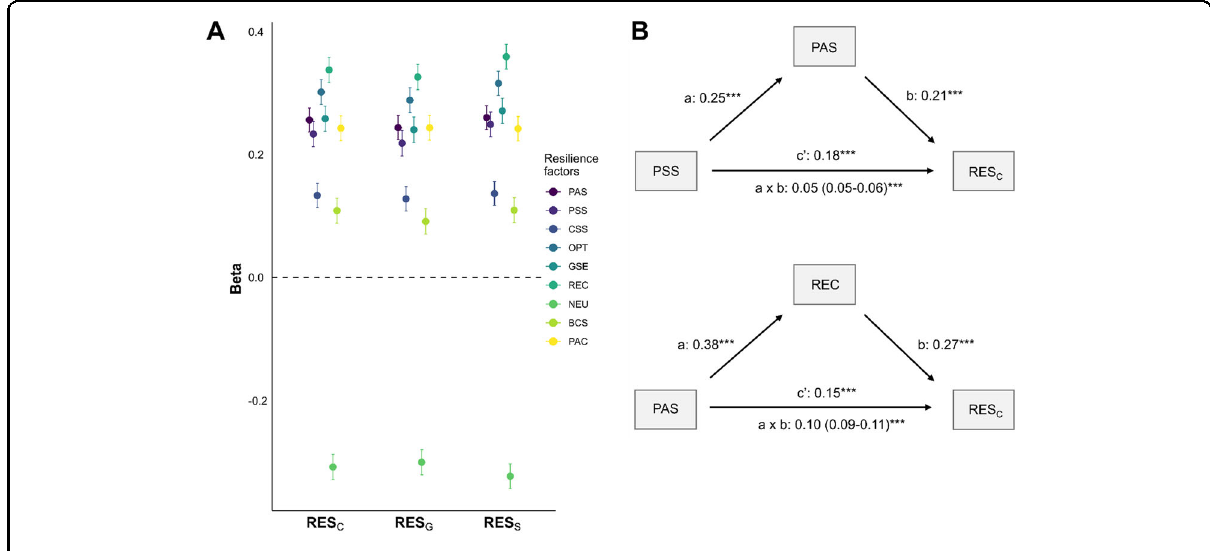
Fig. 1 Associations of hypothesized resilience factors with outcome-based resilience (RES) and mediation effects. A Multiple regressions with covariates of resilience factors on resilience, calculated separately for each factor. Shown are the regression coef fi cients ( β ) and 99% con fi dence intervals (CI). Effects are similar for resilience to all stressors combined (RES C ), resilience to general (RES G ), and resilience to Corona-speci fi c stressors (RES S ). Resilience factors: PAS, positive appraisal style; PSS, perceived social support; CSS, perceived increase in social support during the Corona crisis; OPT, optimism; GSE, perceived general self-ef fi cacy; REC, perceived good stress recovery; NEU, neuroticism; BCS, behavioral coping style; PAC,